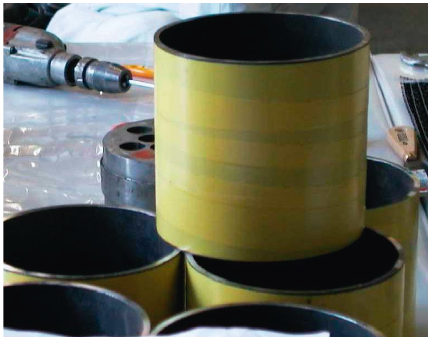
Figure 9: Application of a plastic film on external surface of the metal